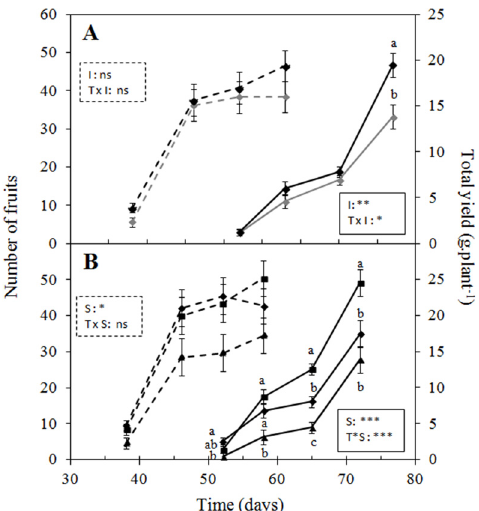
(Table 2). Through the cropping season, the EC was in an acceptable range for plant growth lys [32]. The EC measured at three different depths revealed a salt accumulation in the upper SSE layer of the growing media for PS25 and AB, in contrast with the CF substrate which was packed in bags (Table 2). Salt build-up at the surface is generally caused by the surface evapora- tion, the irrigation system used, and/or the presence of an immobile water phase [42]. Given